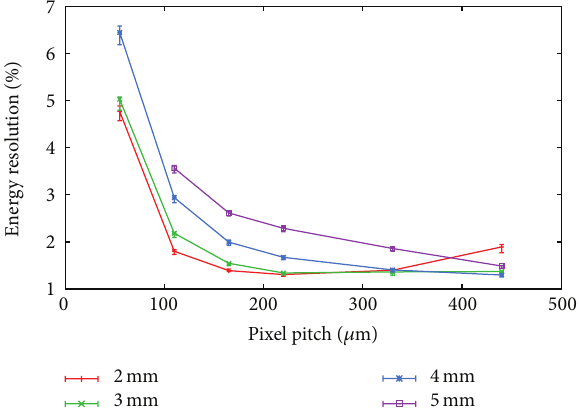
(𝐸 )/𝐸 for FWHM Q Q detector experiment (Cd enriched to 90% in 116 Cd) for various combinations of pixel pitch and sensor thickness. Background sources other than 2 ] 𝛽𝛽 -decays were neglected at this